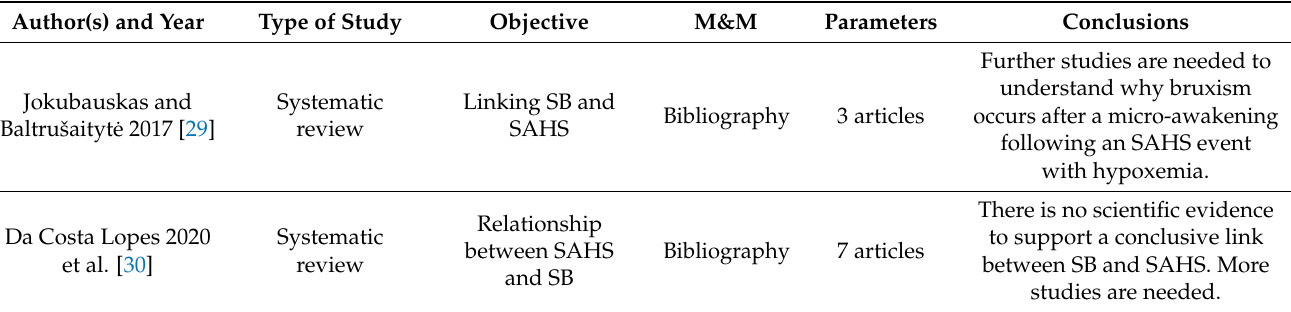
Table 1. Systematic reviews linking SB and SAHS.